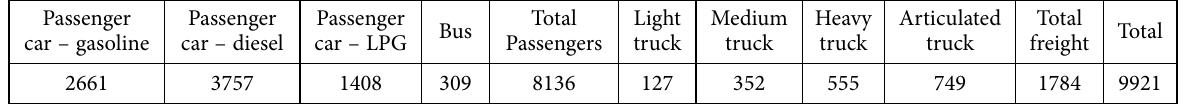
Table 2. Realized traffic volumes on the observed road network [×10 6